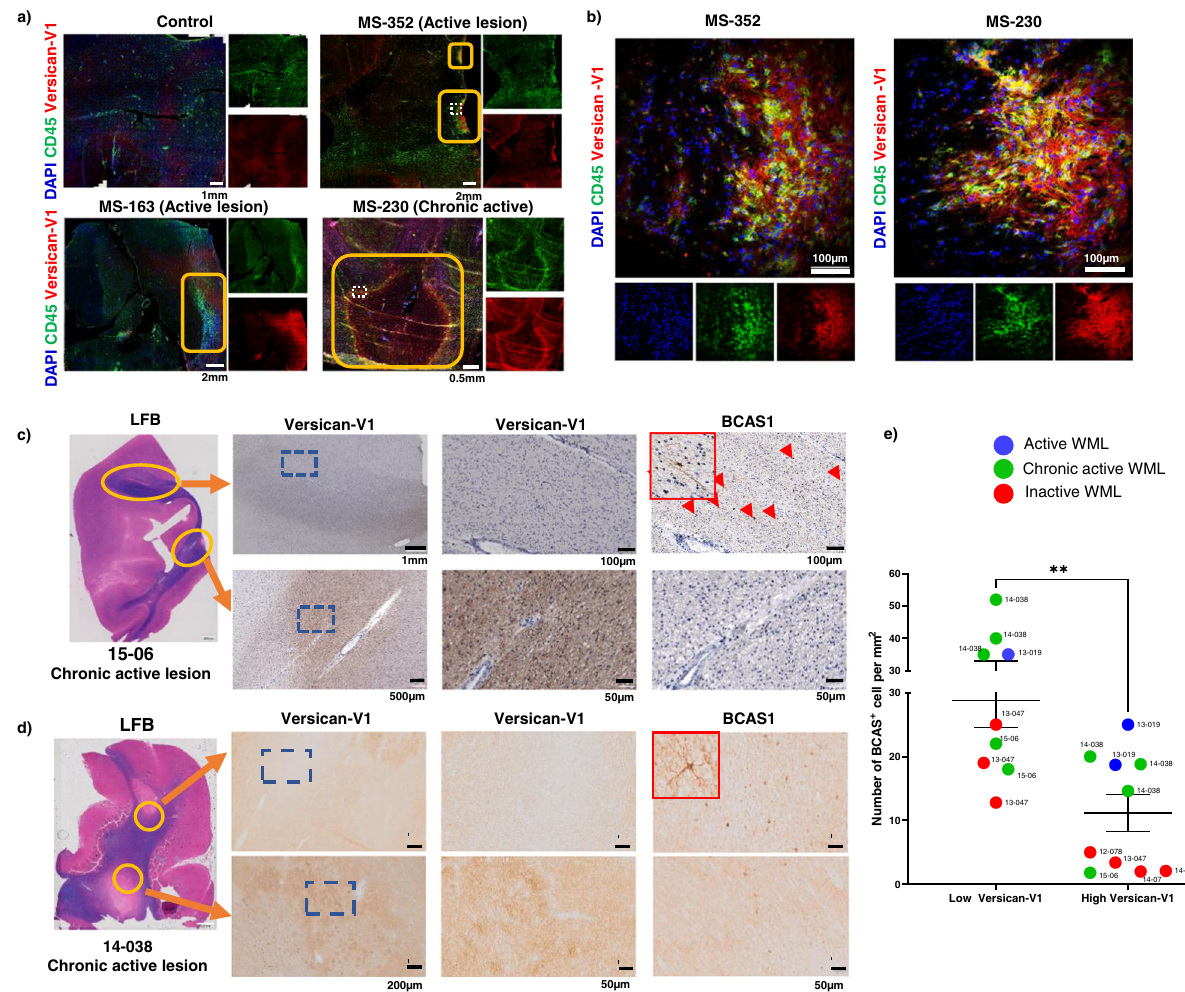
Fig. 1 High level of versican-V1 in MS lesions is associated with low number of BCAS1 + cells. a , b Immuno fl uorescent images comparing control human brain tissue (no documented neurological condition) and MS brain lesions from 3 cases (MS163, 230, 352) labeled with DAPI for cell nuclei (blue), CD45 for immune cells (green) and versican-V1 (red). Active lesion areas were tracked by prominent accumulation of CD45 + cells. Images were acquired with slide scanner a and laser confocal microscopy (b, z-stack). Yellow boxes indicate lesions and dotted white lines specify the areas shown at higher magni fi cation in b . c , d Brain tissue samples from 6 people with MS described in Supplemental Table 1 were immunohistochemically stained for versican-V1 and BCAS1. Representative images from two different patients (15-06 and 14-038) are shown. White matter lesion (WML) areas were tracked by loss of luxol fast blue (LFB) staining. Yellow rings indicate the analyzed sites within the lesions and blue squares in each of the left panels (lower magni fi cation) specify the areas shown at higher magni fi cation to the right. Staining was repeated twice and showed the same results. e Bar graph comparing the number of BCAS1 + cells in 19 regions of interest (ROI) with high or low level of versican-V1 deposition, n = 19 ROIs from 9 lesions acquired from six individual MS brain samples. Data are represented as mean ± SEM. Two-tailed Mann – Whitney U-test; signi fi cance indicated as ** p = 0.0029. Source data are in the source data fi